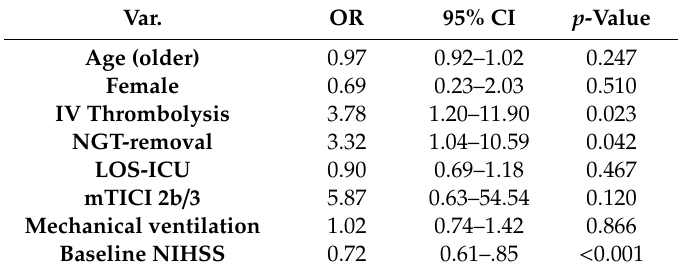
Table 2. Multivariate logistic regression model for predictors of 90-day good outcome (mRS 0–2). Var.